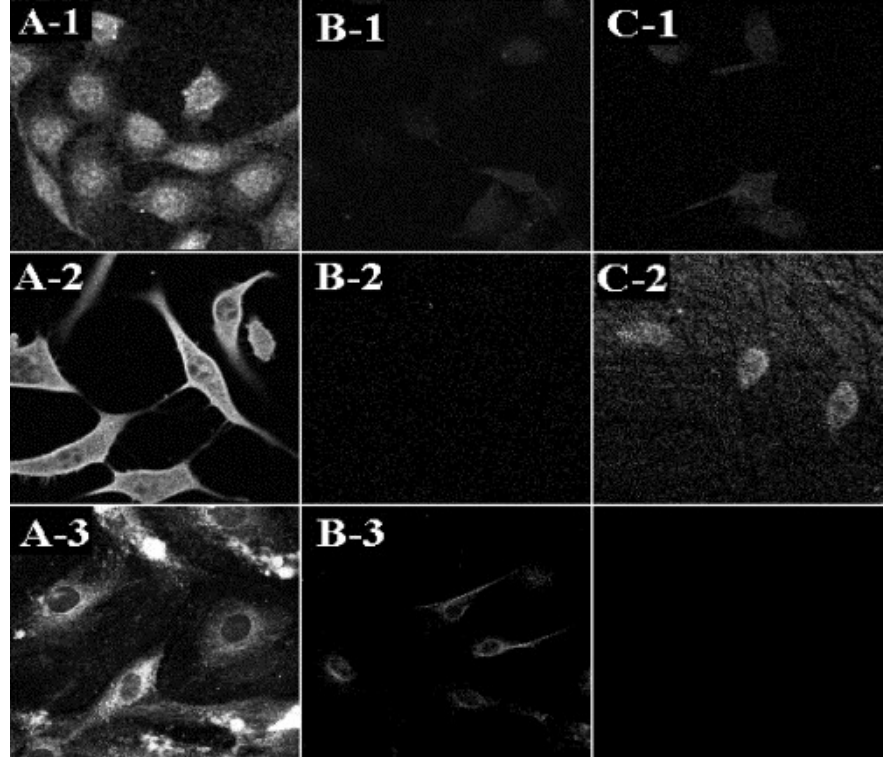
Figure 5. CLS micrographs showing intracellular fluorescence in fibroblasts following delivery of various fluorescent probes by ethosomes and control systems. Fluorescent probes (D289: A1 – C1